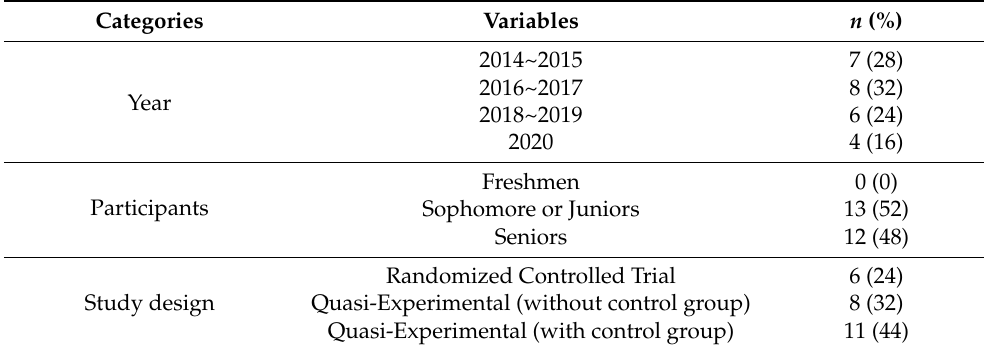
Table 2. General features of simulation studies ( n = 25).